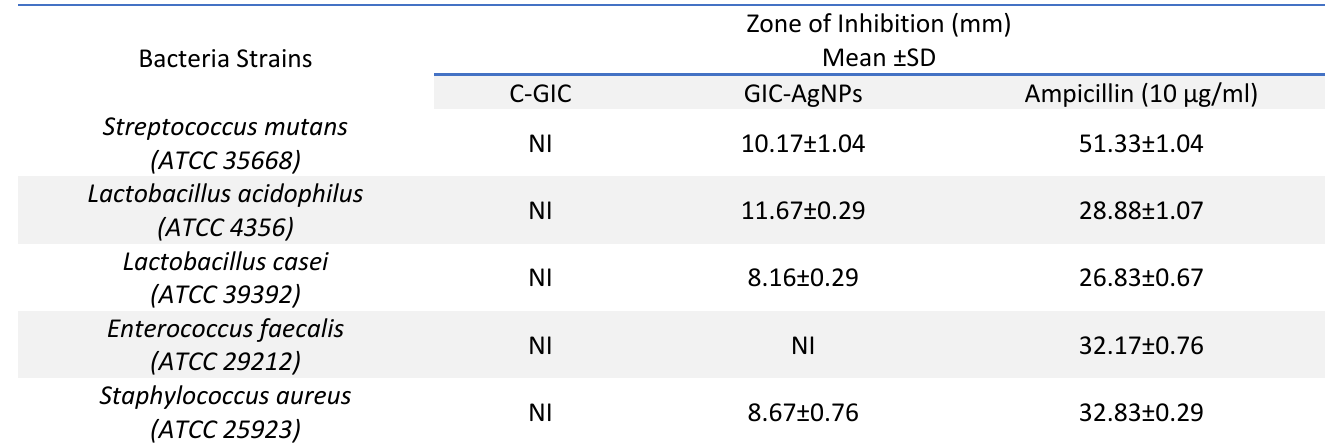
C-GIC: Conventional Glass Ionomer Cement, GIC-AgNPs: GIC with 2 wt% AgNPs, NI: No inhibition zone